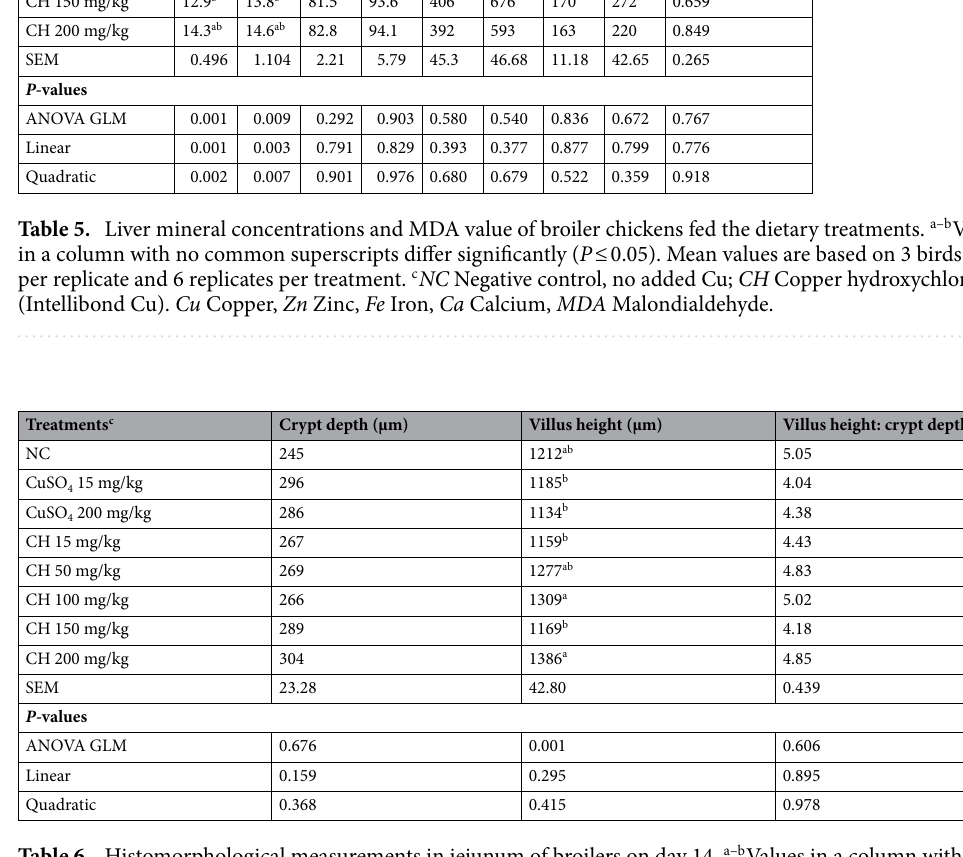
Table 6. Histomorphological measurements in jejunum of broilers on day 14. a–b Values in a column with no common superscripts differ significantly ( P ≤ 0.05). Mean values are based on 3 birds per replicate and 6 replicates per treatment. c NC Negative control, no added Cu, CH Copper hydroxychloride (Intellibond Cu).